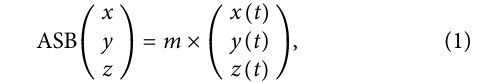
Figure 8 are time-dependent ellipsoid scaling factors along the axes. For example, if a ( t ) > c ( t ) , then ellipsoid will be extended along the x-axis and likewise. Similarly, the minimum separation distance between two UAVs is given as